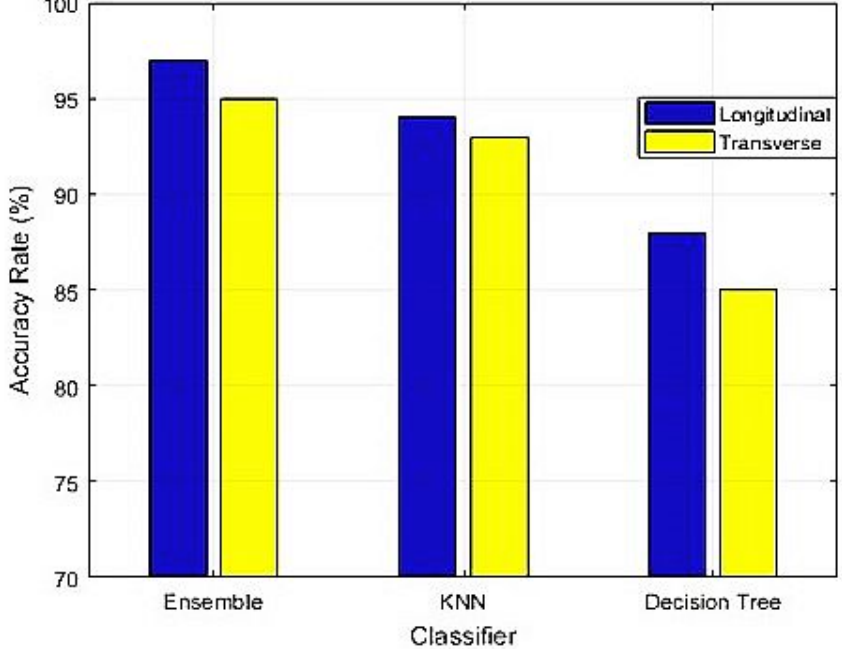
Figure 8. Classification accuracy graph of OASBUD dataset.